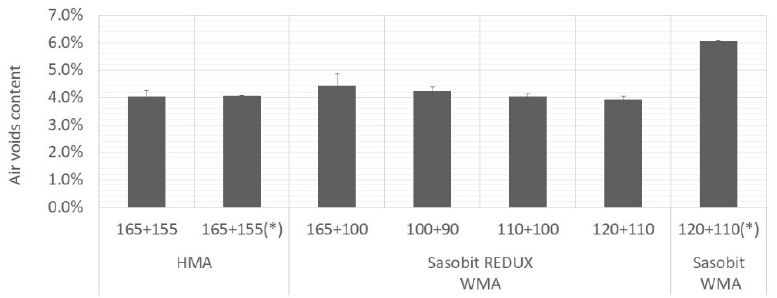
Figure 4. Variation of air voids content with mixture and temperature.